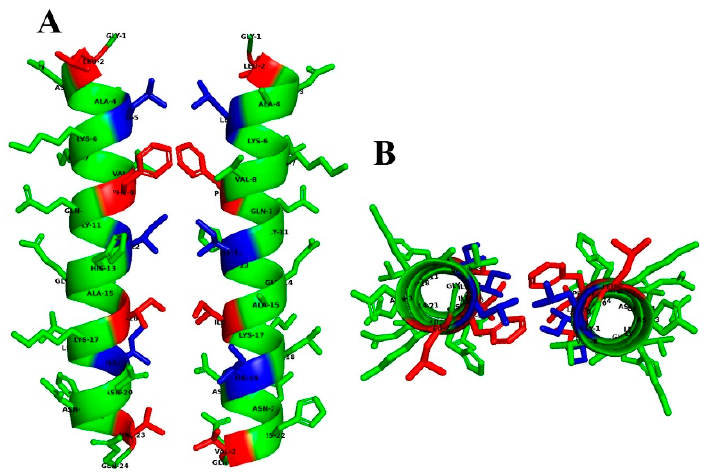
Figure 2. 3D model of pseudin-2 in an aqueous solution. Side ( A ) and top ( B ) views of pseudin-2 in the leucine-zipper orientation determined via 3D structure modeling using the PEP-FOLD server (https://bioserv.rpbs.univ-paris-diderot.fr/services/PEP-FOLD3/) [26,27]. Blue and red colors indicate amino acids that could be substituted at P1 and P2 positions, respectively.